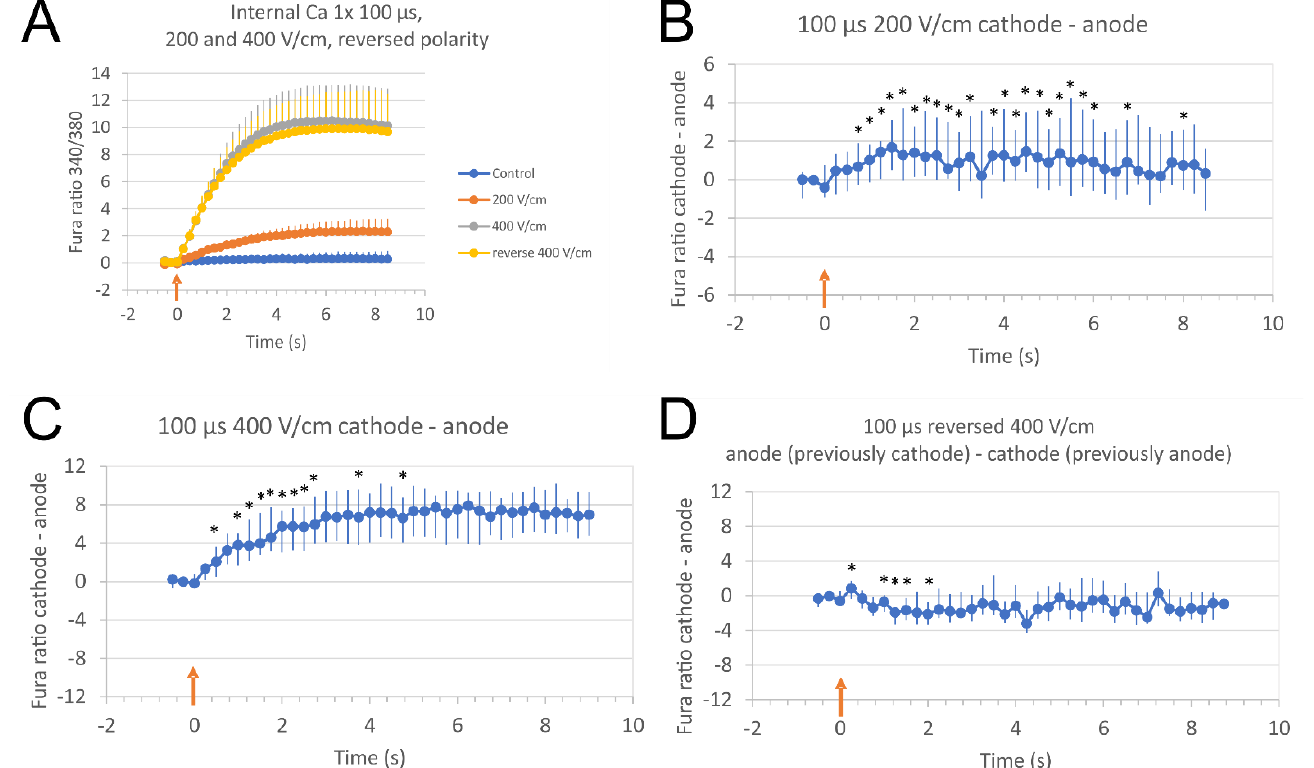
Figure 7. Relative Ca 2+ concentration in cells after single, 100 µ s of low electric field strength, or reversed polarity pulses. Relative Ca 2+ concentration in cells was monitored with a fluorescent calcium indicator Fura-2, image acquisition was done every 250 ms. Time of pulse application is noted with a red arrow. ( A ): Single pulses of 100 µ s were applied consecutively on the same cells (with a pause for recovery in-between): 200 V/cm (low electric field strength, red), 400 V/cm (regular, as in other experiments using 100 µ s, grey), and 400 V/cm with reversed polarity (yellow). Results are presented as mean ± SD from four experiments (15–19 cells analyzed, all cells are taken into account). ( B – D ): Fura ratio difference between cathode and anode in cells (both parallel and perpendicular cells together) after low electric field strength (200 V/cm) ( B ), regular (400 V/cm) ( C ), or reversed polarity 400 V/cm ( D ) single pulses. Single pulses of 100 µ s were applied